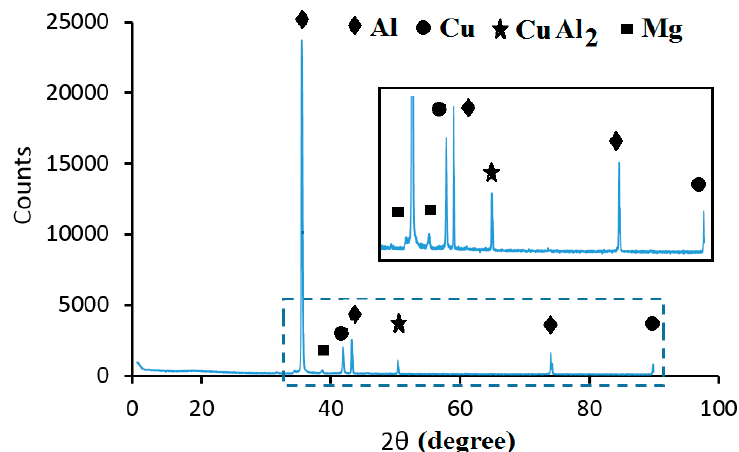
Figure 18. XRD spectrum of the fracture surface for joints bonded with pure-Cu for 10 min.